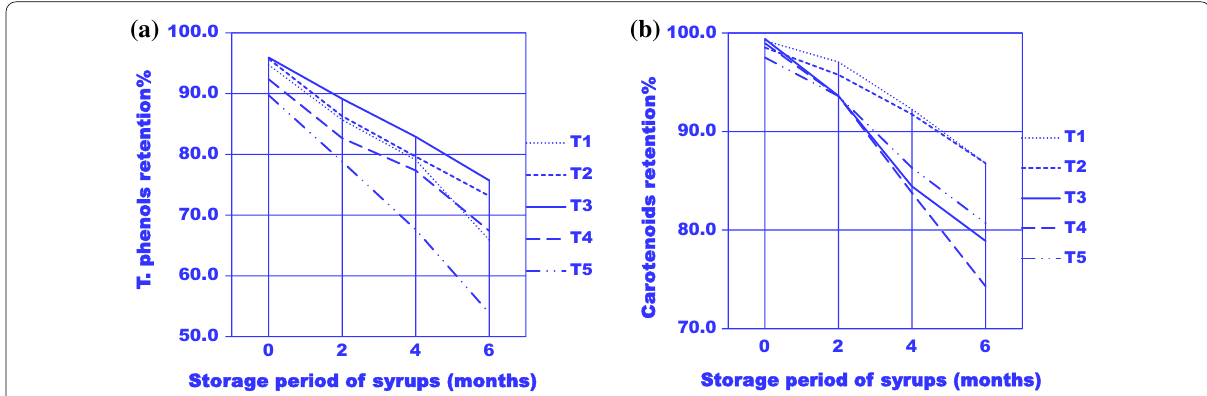
Fig. 3 Retention of total phenols and carotenoids in different syrups during the storage period